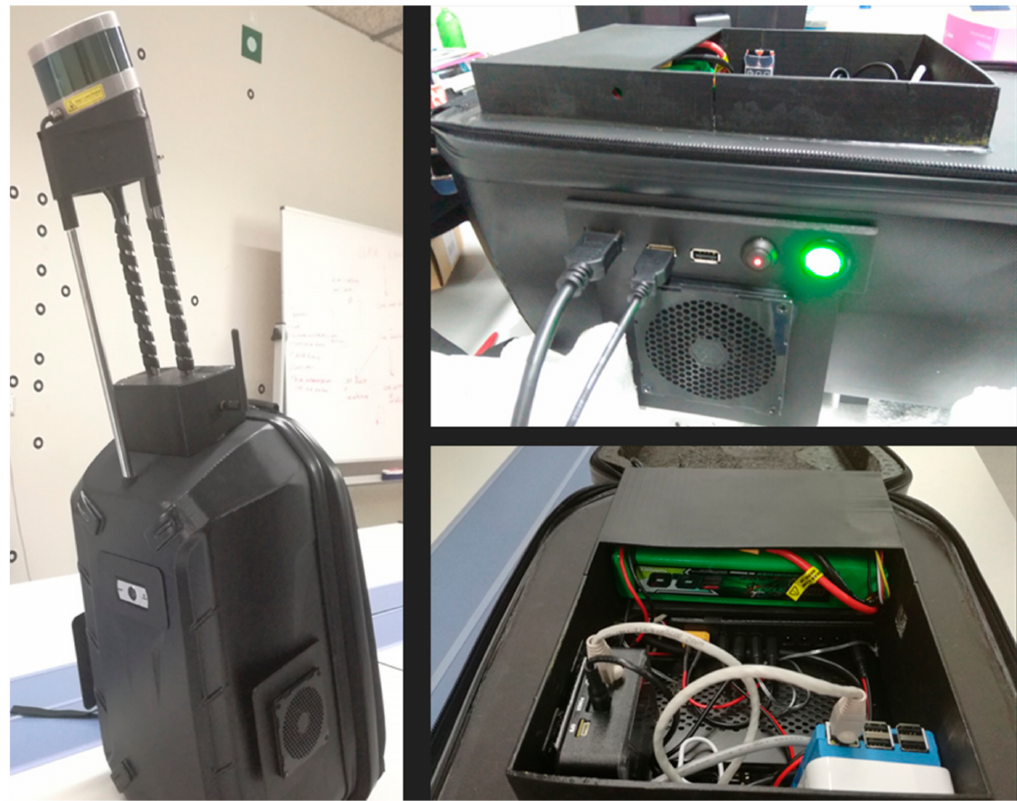
Figure 1. ( Left ) General view of the wearable prototype. ( Right ) Detail of the interior of the wearable